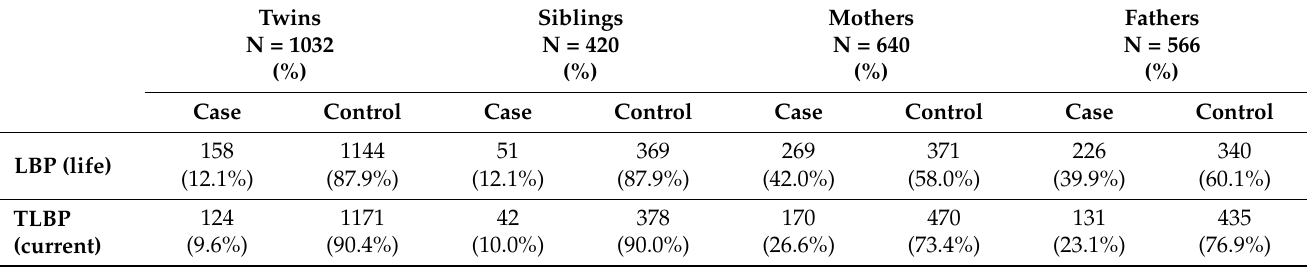
Table 2. Sample size (N) and percentage (%) for cases and non-cases (controls) for LBP and TLBP for twin individuals, mothers, fathers, and oldest siblings.